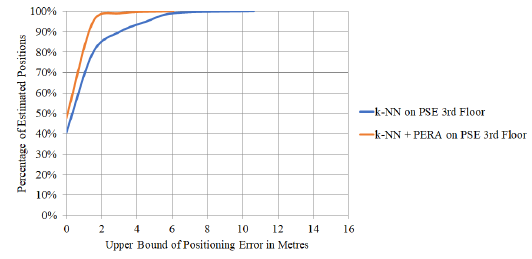
Figure 7. Cumulative Positioning Error on 3 rd Floor of